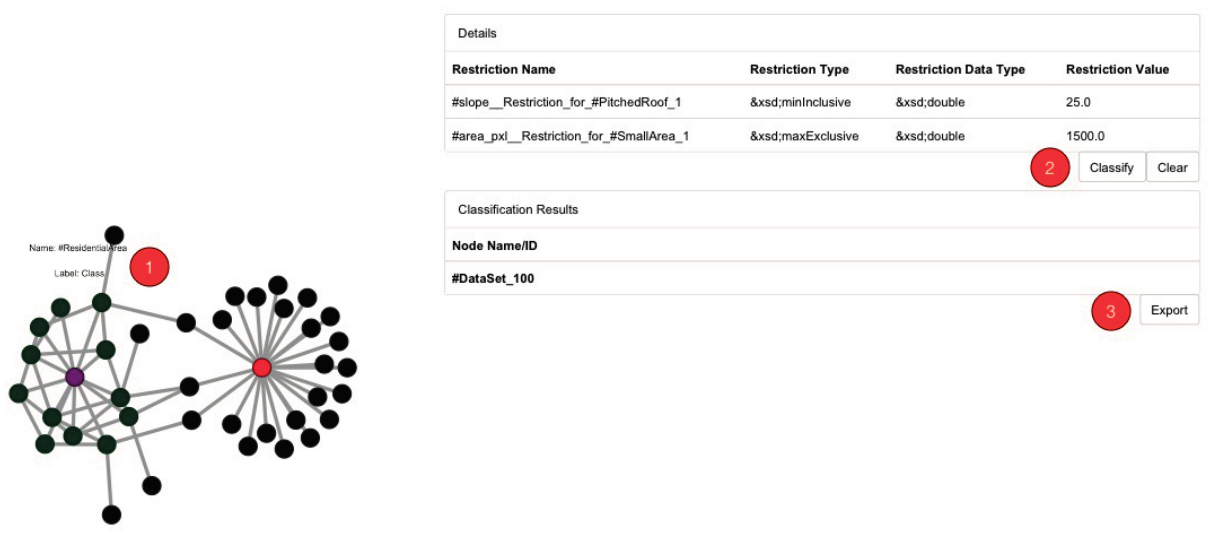
Figure 4. Web-based frontend to issue queries to the